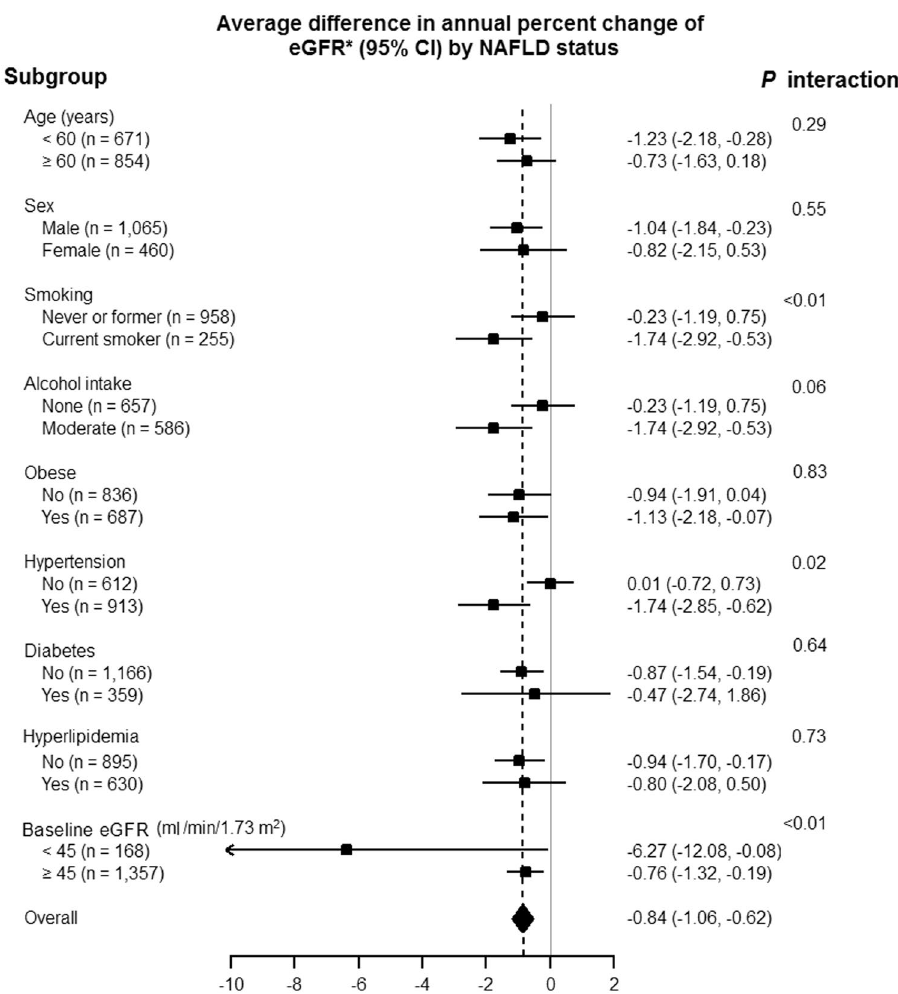
* Expected annual percent changes were derived from linear mixed effects models for log-transformed eGFR adjusted for baseline age, sex, year of visit, baseline smoking status (never, former, current, and missing), alcohol (none and moderate), body mass index, hypertension, diabetes, hyperlipidemia, systolic blood pressure, hemoglobin A1c, LDL cholesterol, and triglycerides (log e -transformed).